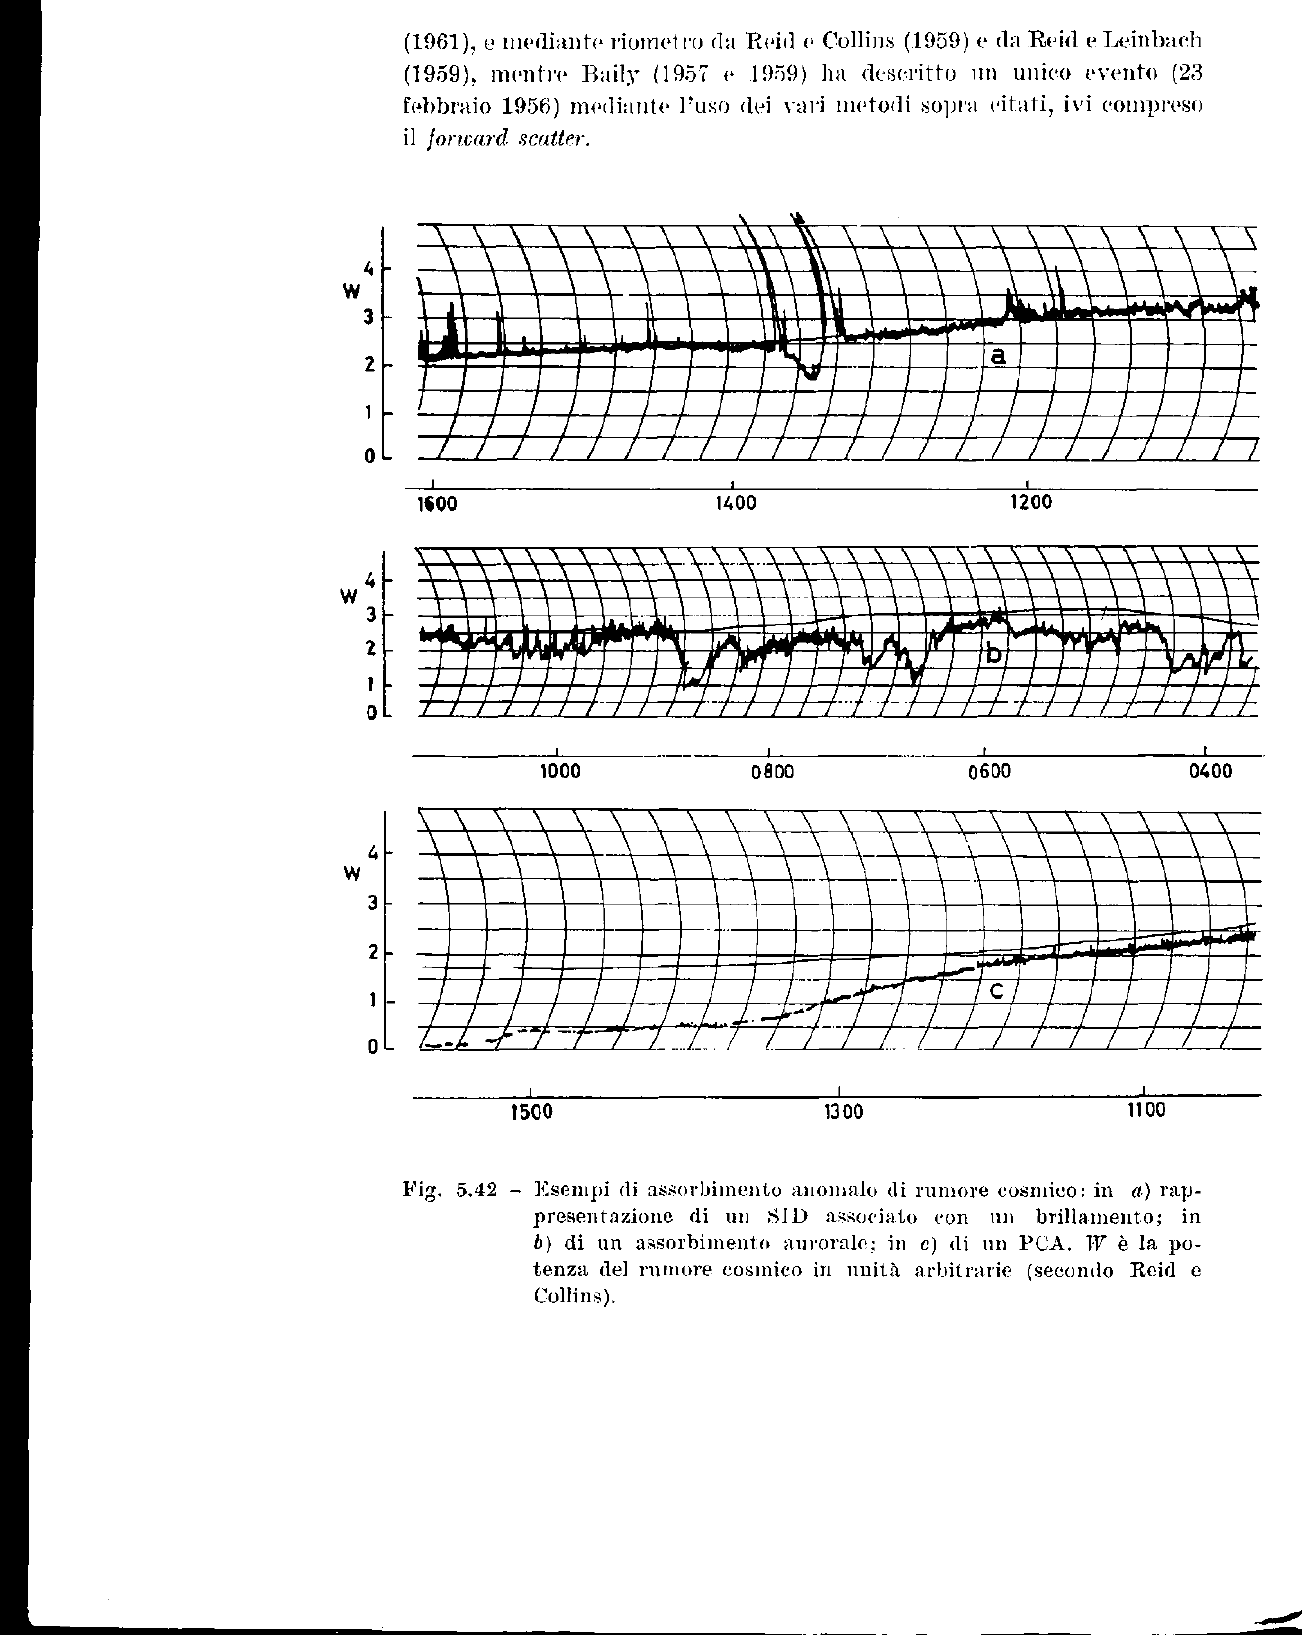
Fig. 5.42 - Esempi di assorbimento anomalo di rumore cosmico: in a) rap- presentazione di un SID associato con un brillamento; in b) di un assorbimento aurorale; in c) di un PCA. W è la po- tenza del rumore cosmico in unità arbitrarie (secondo Reid e